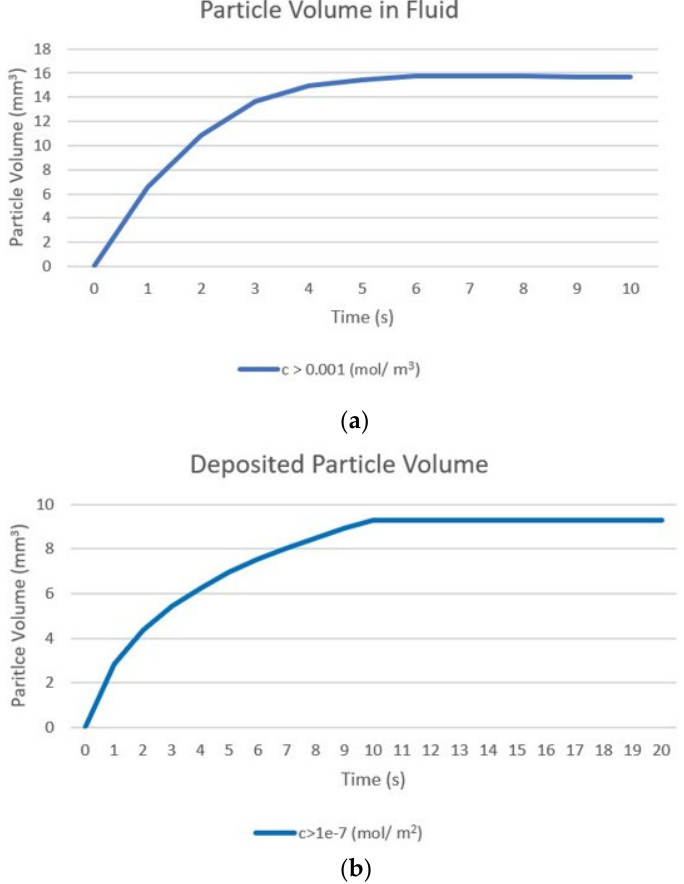
Figure 11. Change in the calculated volume of particles from the start of injection to 10 s post-injection: ( a ) within the fluid, threshold 1 × 10 − 6 mol/m 3 ; ( b ) deposited onto cell surfaces, threshold 1 × 10 − 9 mol/m 2 .